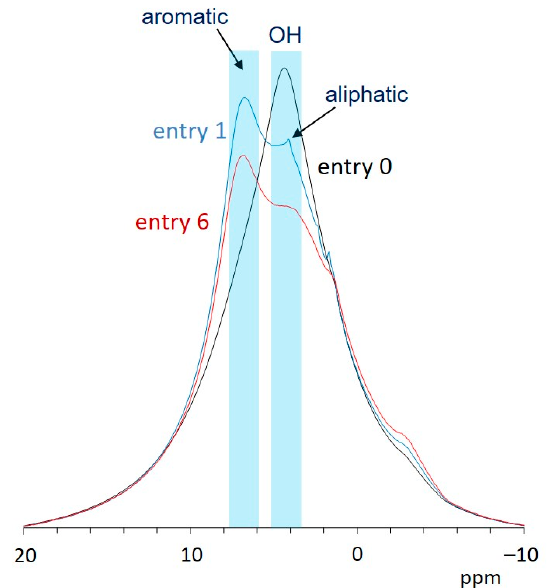
Figure 4. 1 H MAS NMR spectra of degreased wood (entry 0, black) and benzylated woods (entry 1, blue; and entry 6, red).